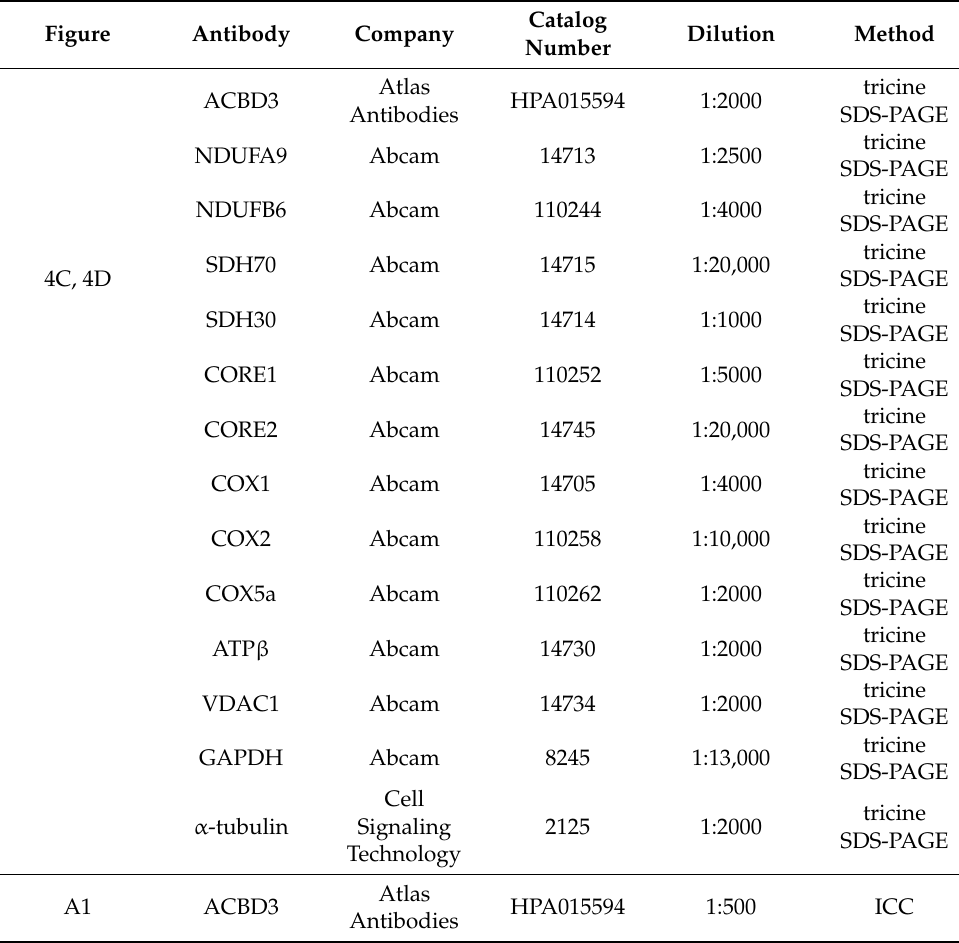
Table A3. Cont. Figure